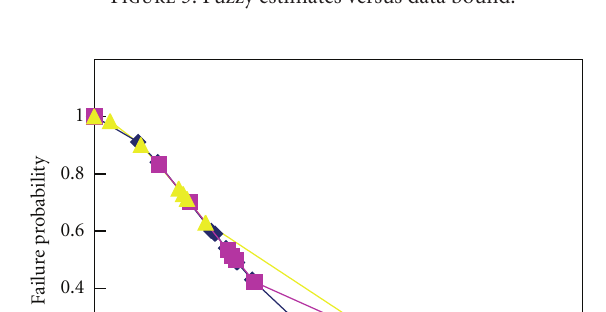
Figure 3: Fuzzy estimates versus data bound.